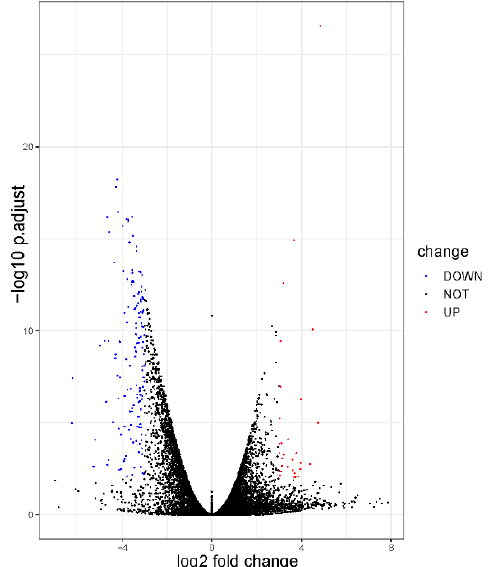
Figure 5. Volcano plot of the differentially expressed genes (DEGs) between Yunling and Leiqiong cattle pituitary glands. The red dots represent the upregulated transcripts (log 2 fold change > 3, false discovery rate (FDR) < 0.01), and the blue dots represent the downregulated transcripts log 2 fold change < − 3, false discovery rate (FDR) < 0.01).